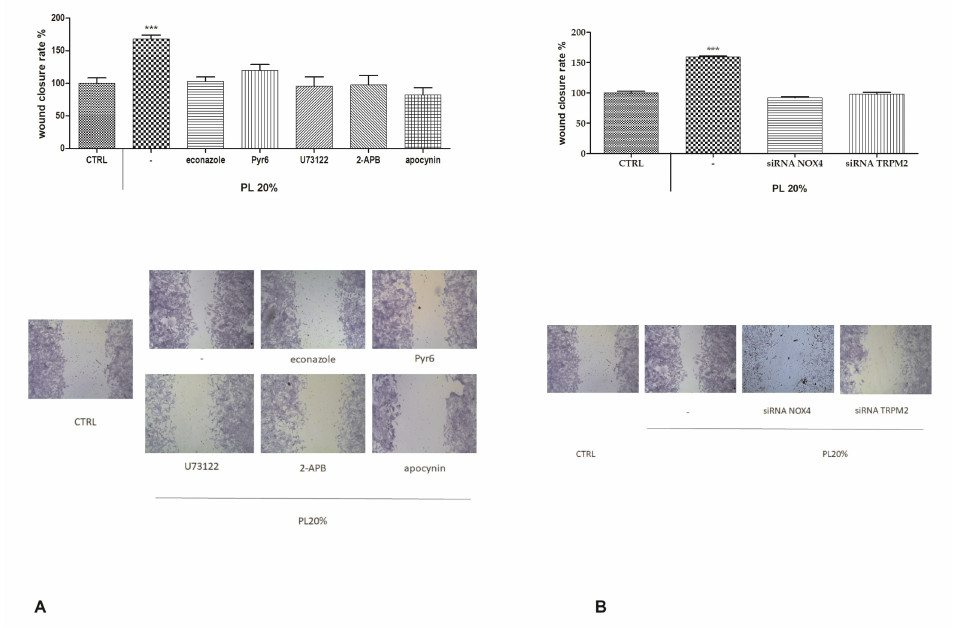
Figure 8. Role of intracellular ROS and Ca 2 + in PL-induced wound closure. A. Upper panel: E ff ect of di ff erent inhibitors on PL-induced scratch wound repair of endothelial monolayers. Each inhibitor was used according to the procedures, which were previously shown to inhibit PL extracellular Ca 2 + entry. CTRL are cells in control conditions, i.e., cells grown in DMEM with 10% FBS as described in the Materials and Methods section. Wound closure rate is expressed as the di ff erence between wound width at 0 and 24 h. Data were recorded 24 h after scratch wound healing of cells exposed to PL. Bars represent mean ± s.e.m. of wound closure inhibition deriving from two independent experiments, each with n = 20. Asterisks on bars indicate statistical di ff erences determined by two-way ANOVA with Bonferroni’s correction ( p < 0.001). Lower panel: Micrographs of scratch-wounded bEND5 monolayers incubated under control conditions or in the presence of PL with di ff erent inhibitors. B. Upper panel: E ff ect of RNAi for NOX4 and TRPM2 on PL-induced scratch wound repair of endothelial monolayers. Wound closure rate is expressed as the di ff erence between wound width at 0 and 24 h. Data were recorded 24 h after scratch wound healing of cells exposed to PL. Bars represent mean ± s.e.m. of wound closure inhibition deriving from two independent experiments, each with n = 20. Asterisks on bars indicate statistical di ff erences determined by two-way ANOVA with Bonferroni’s correction ( p < 0.001). Micrographs of scratch-wounded bEND5 monolayers incubated under control conditions (scrambled cells) or in the presence of PL and RNAi (siRNA) for NOX4 and TRPM2 and then stained with blue toluidine and observed 24 h after